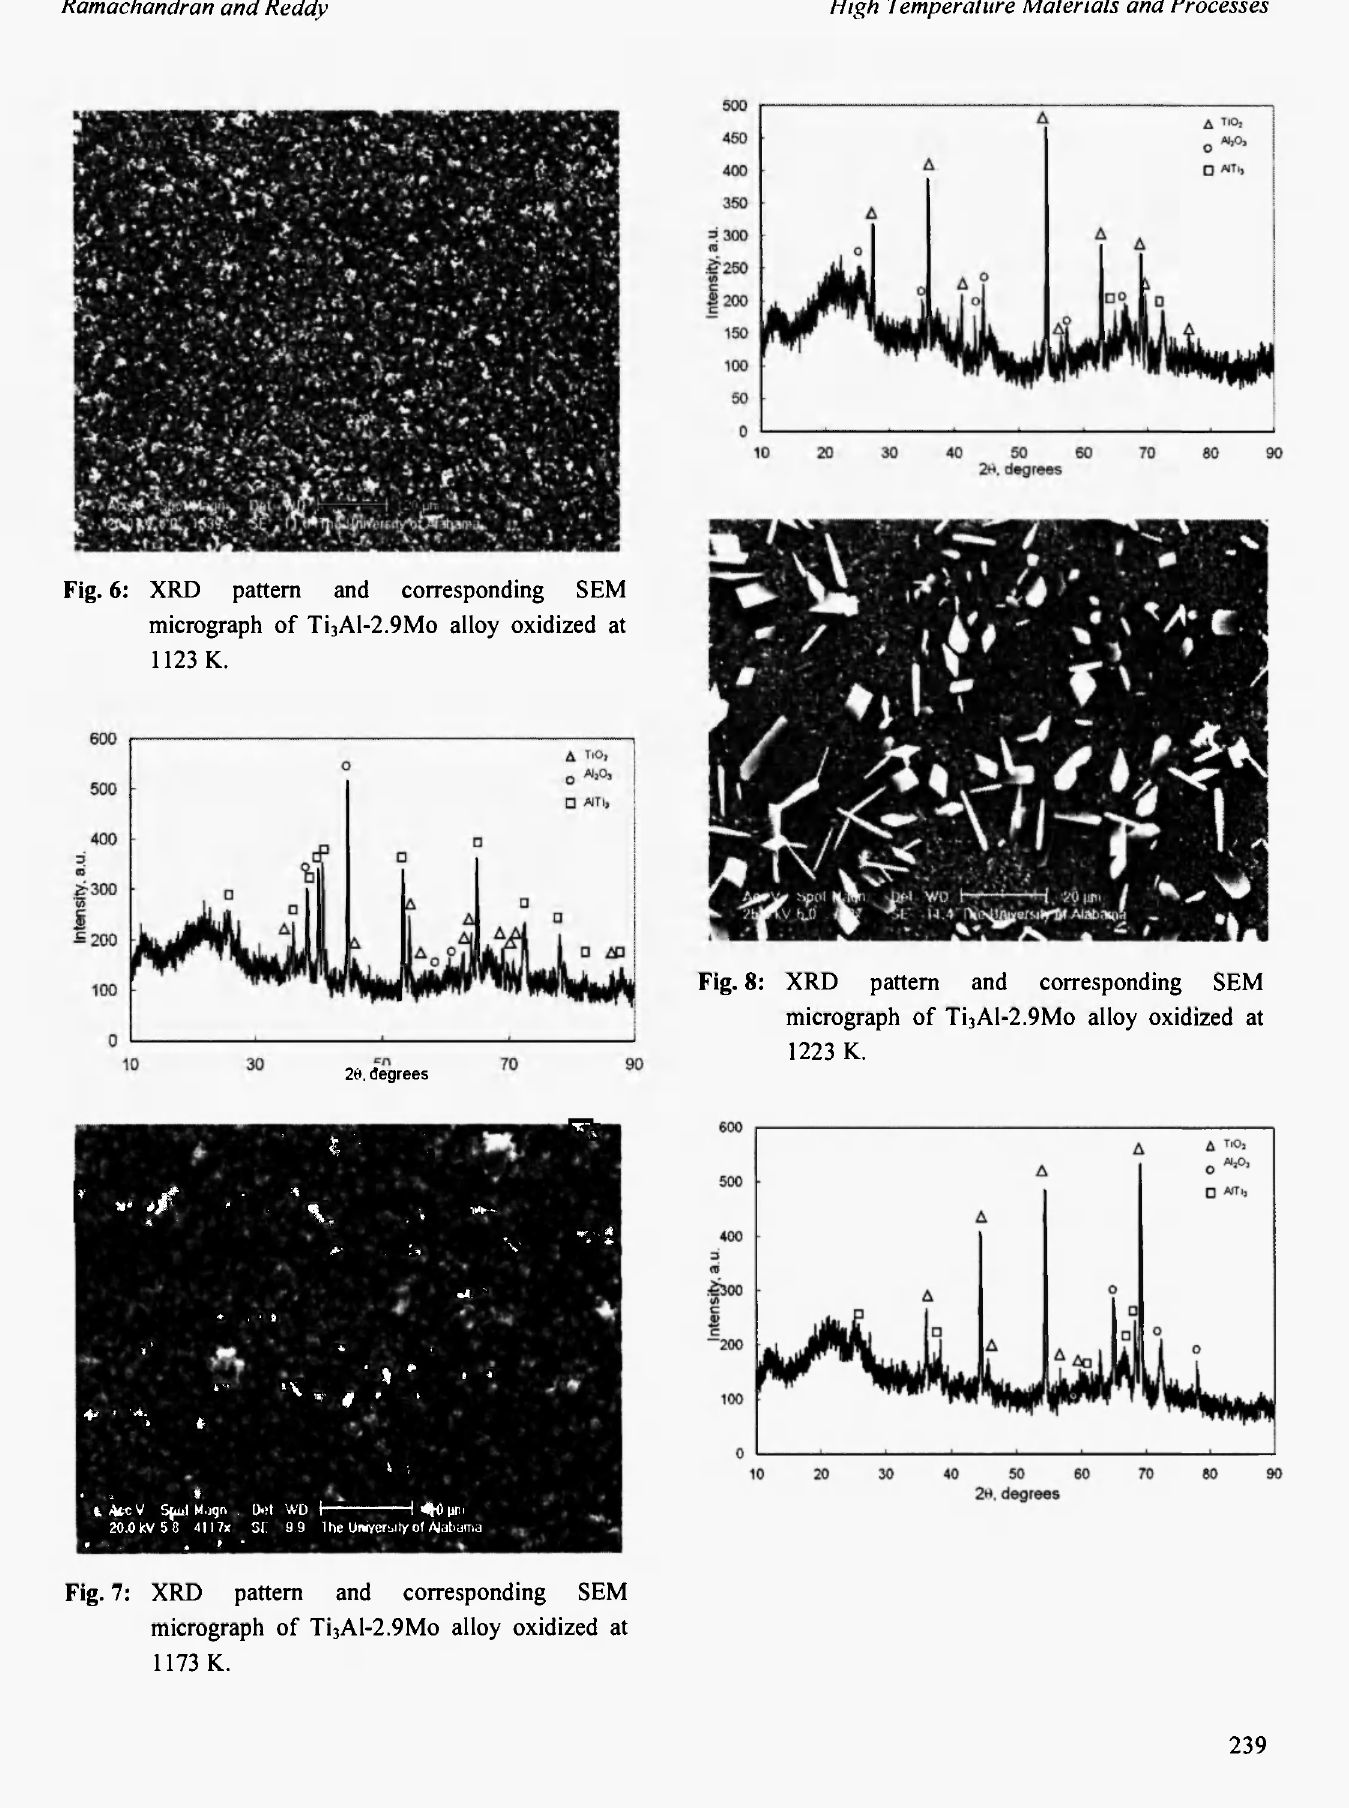
Fig. 6: XRD pattern and corresponding SEM micrograph of Ti 3 Al-2.9Mo alloy oxidized at 1123 K.